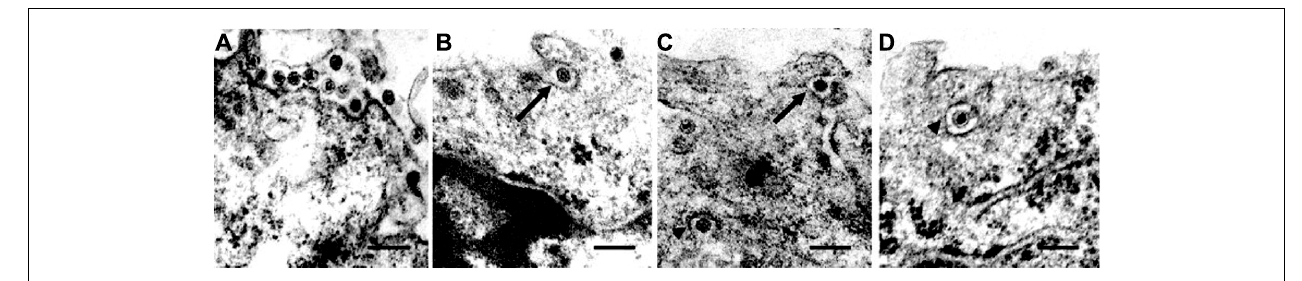
FIGURE 1 | Cell entry of Rice dwarf virus (RDV) via the clathrin-mediated endocytosis pathway. (A) Attachment of RDV particles to the plasma membranes of vector cell monolayers (VCMs) 30 min p.i. (B,C) Uptake of RDV